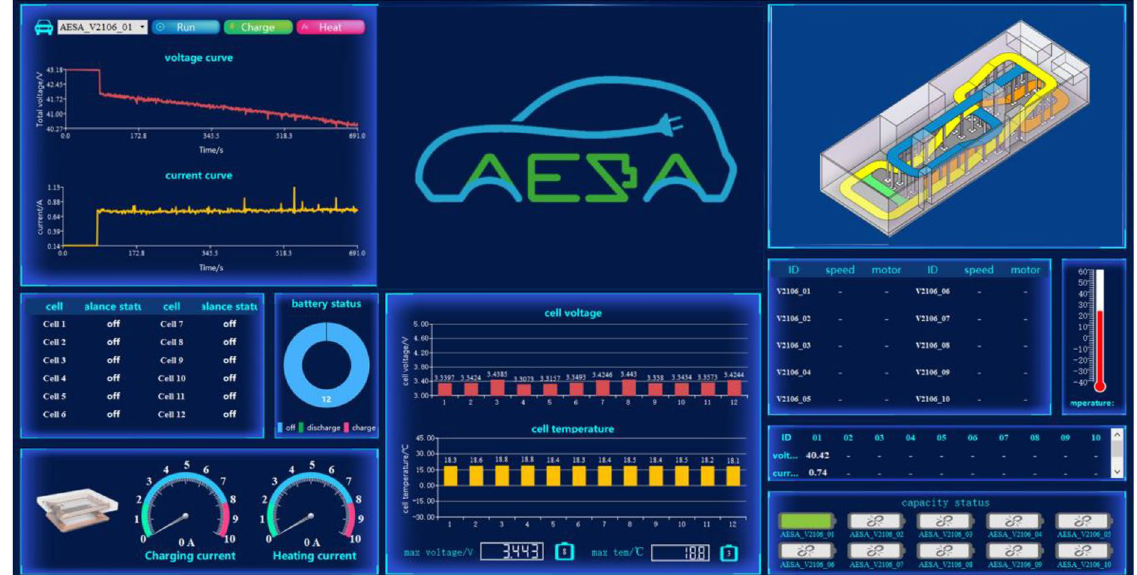
Figure 9 Real-time monitoring interface of upper